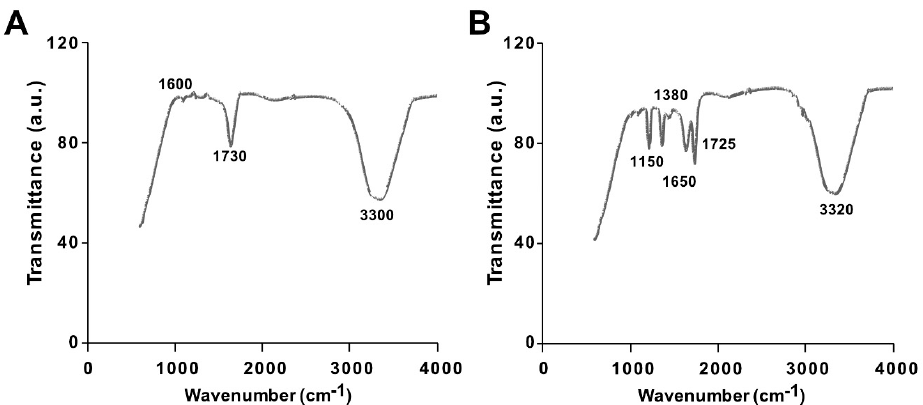
Figure 2. Characterization of GO and GO-PtNPs by Fourier-transform infrared spectroscopy (FTIR). FTIR images of GO ( A ) and GO-PtNPs ( B ). At least three independent experiments were performed for each sample and reproducible results were obtained.